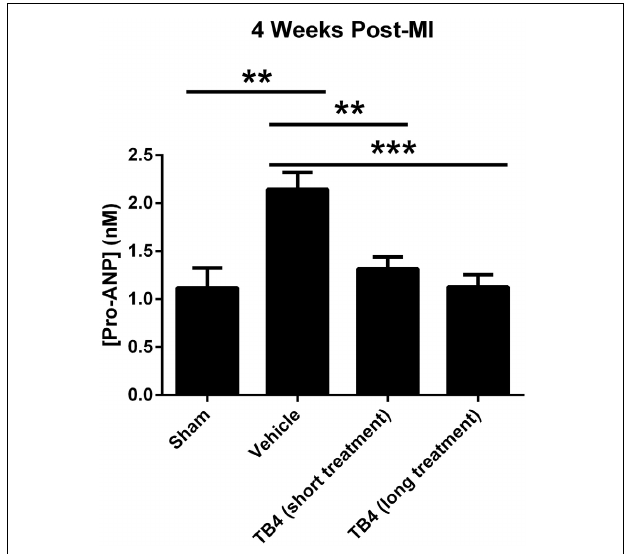
FIGURE 4 | Plasma pro-ANP levels 28 days post-MI surgery. T β 4 treatment significantly reduced plasma pro-ANP levels 28 days after MI surgery. ∗∗ P < 0 . 01, Sham vs. MI + Vehicle; ∗∗ P < 0 . 01, MI + Vehicle vs. T β 4 (short treatment); ∗∗∗ P < 0 . 001, MI + Vehicle vs. T β 4 (long treatment).